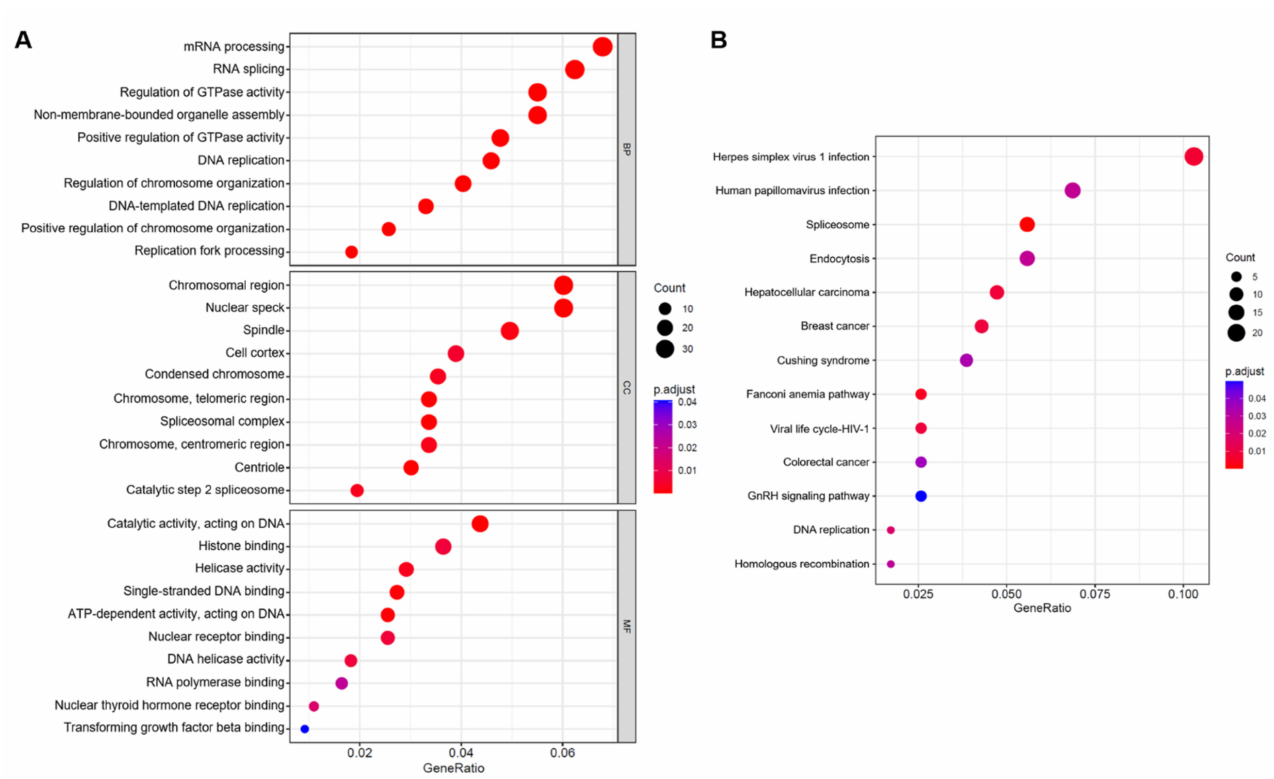
Figure 2. GO and KEGG enrichment analysis results of 612 overlapping DEGs. ( A ) The enriched GO terms consisted of biological process, cellular component, and molecular function. ( B ) KEGG analysis for DEGs. GO: Gene Ontology; KEGG: Kyoto Encyclopedia of Genes and Genomes; DEG: differentially expressed